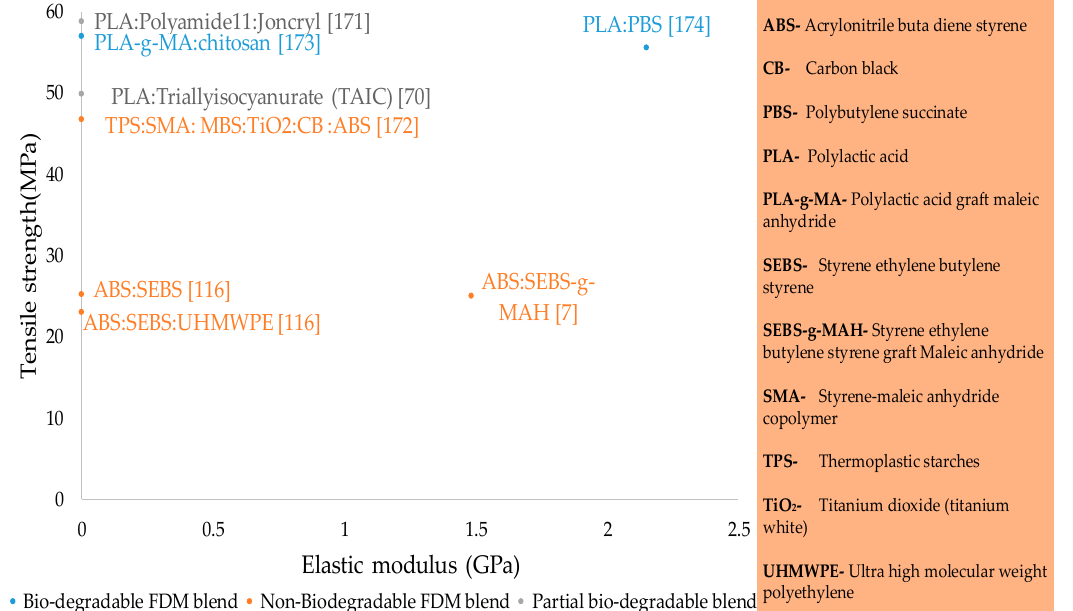
Figure 16. Tensile strength and elastic modulus of blend materials in fused filament fabrication.